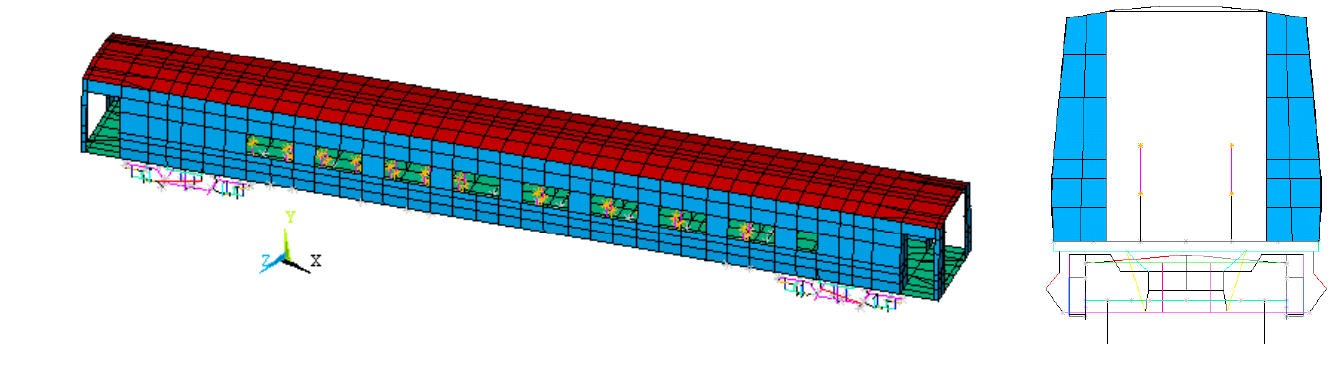
Figure 9. Numerical model of BBN vehicle.